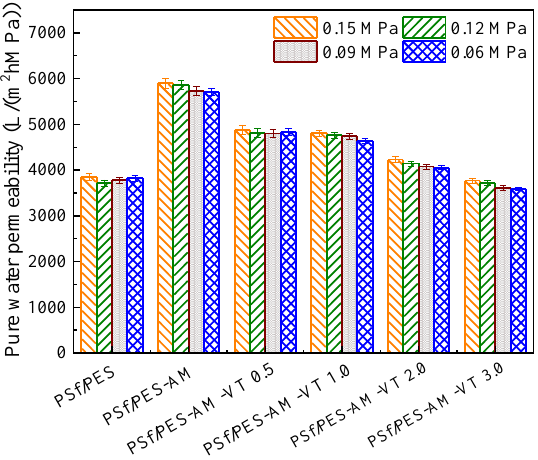
Figure 9. Pure water permeability of various membranes during the pure water filtration.